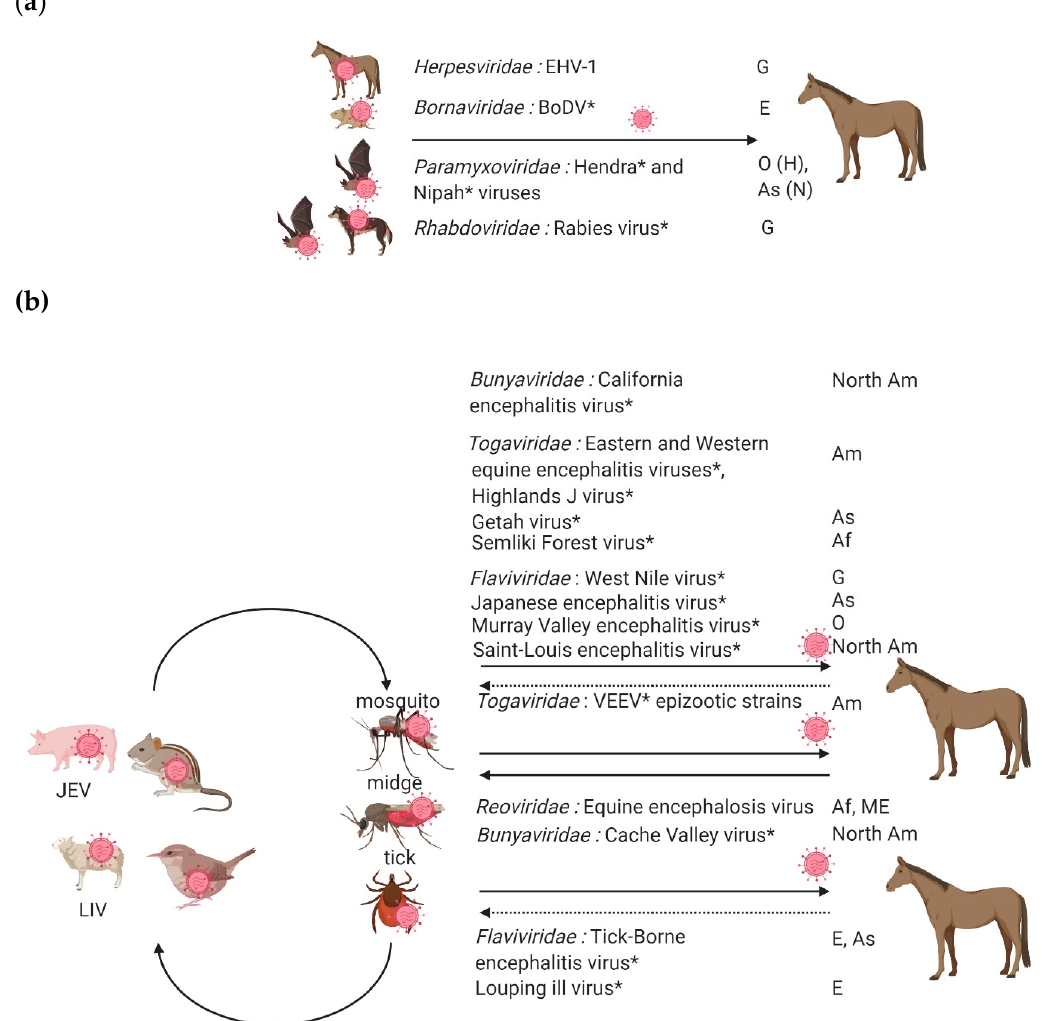
Figure 3. Encephalitis viruses in equines. Transmission mode (direct transmission in ( a ) or arthropod-borne transmission in ( b )), zoonotic potential (zoonotic viruses are marked with an asterisk) and geographical distribution (Af for Africa, Am for America, As for Asia, E for Europe, ME for Middle East, O for Oceania and G for global) are presented. EHV-1: Equid alphaherpesvirus 1; BoDV: Borna disease virus; VEEV: Venezuelan equine encephalitis virus. Black arrows represent established virus transmission between the two partners. Doted arrows indicate limited virus transmission possibility from the infected horse to its reservoir, with the exception of midge-borne arboviruses and of the mosquito borne VEEV epizootic variants for which horses serve as amplifier hosts. The figure was prepared on BioRender